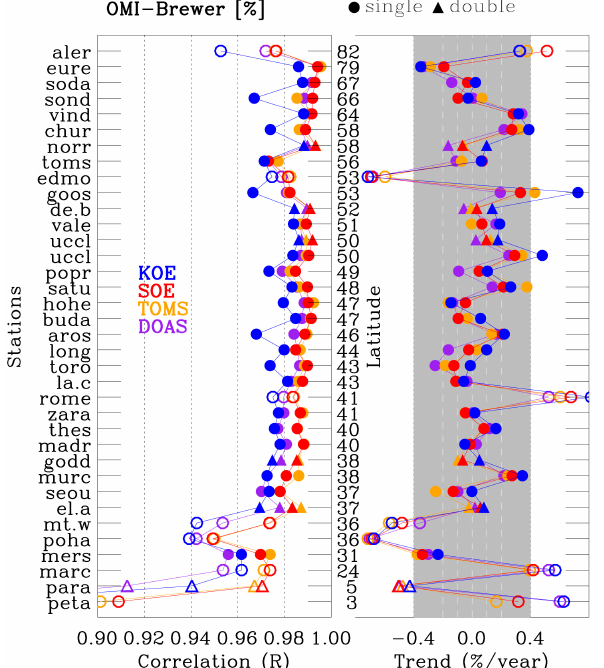
Figure 2. Same as Fig. 1, but for correlation coefficient ( R ) and trends (%yr − 1 ). The correlation coefficient is calculated between OMI and Brewer total ozone columns. The trend is derived from the linear regression of the monthly differences between OMI and Brewer total ozone columns.